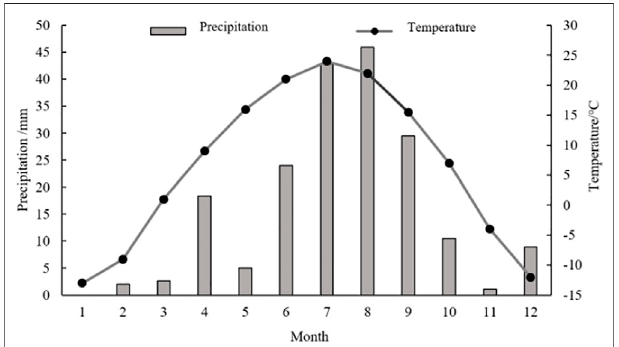
FIGURE 2 | Mean monthly precipitation and temperature in 2019.